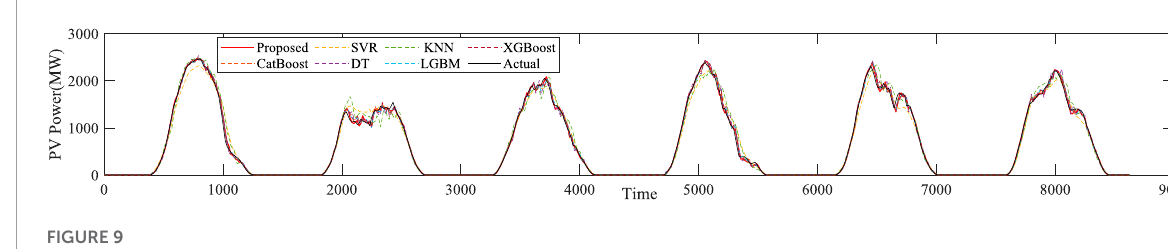
FIGURE 9 15-minutes-ahead forecasting results in fall.